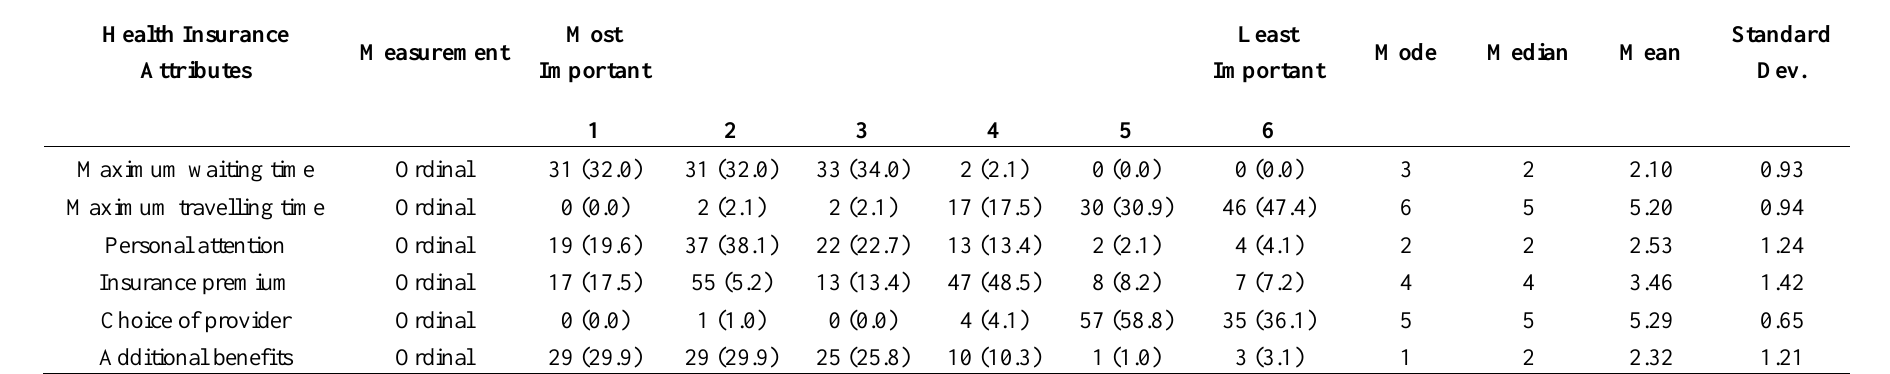
Table 5 . Relative importance of health insurance attributes (self-explicated ranking) - ranking frequency N [%]